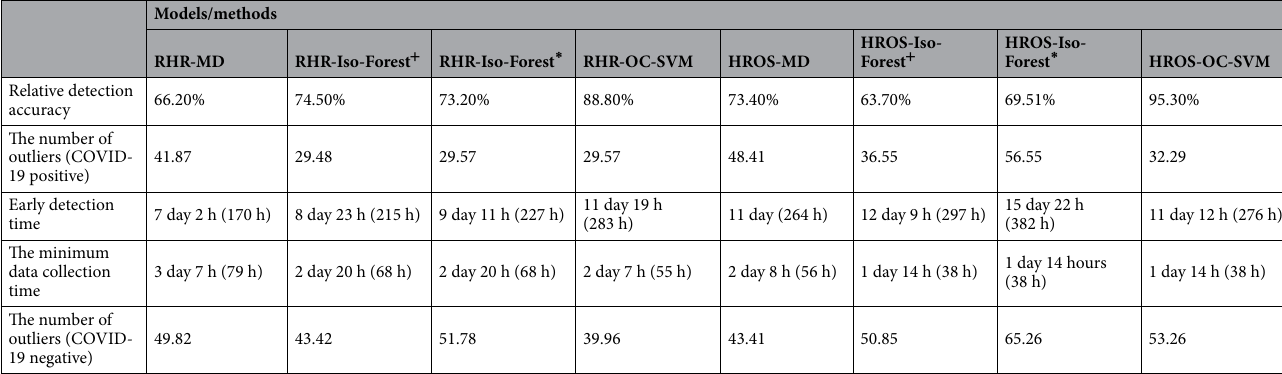
Table 4. Comparison between 3 methods, MD-MCD, OC-SVM, isolation forest (Iso-Forest). ** RHR-Iso- + + Forest and HROS-Iso-Forest set 0.1 to the contamination parameter and RHR-Iso-Forest ∗ Forest set ’auto’ to the contamination